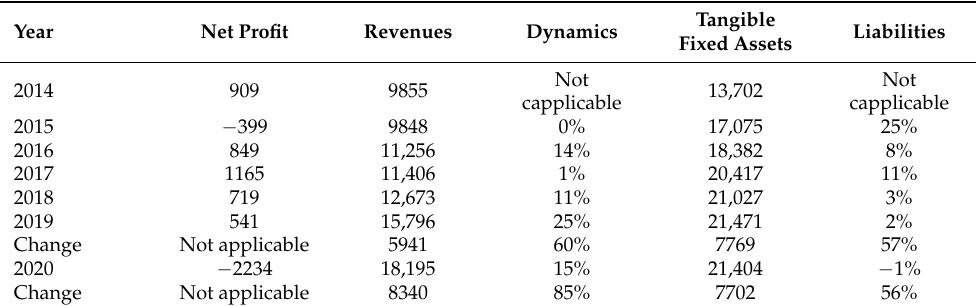
Table 10. Net profit, revenues and property, Tangible fixed assets of ENEA Capital Group in 2014–2020 (in PLN million).